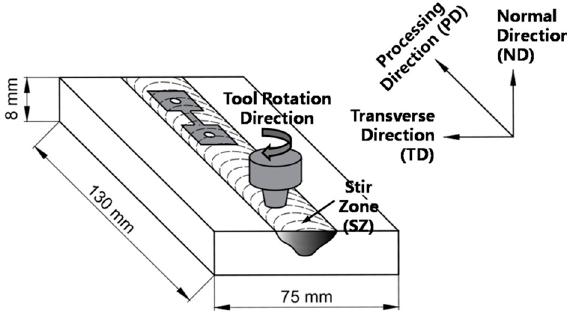
Figure 1. Schematic of friction stir processing (FSP) in this study.